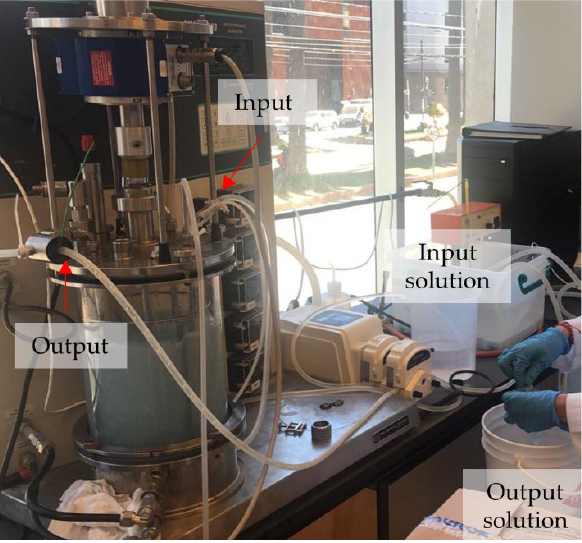
Figure A2. Photo of the continuous abiotic system.